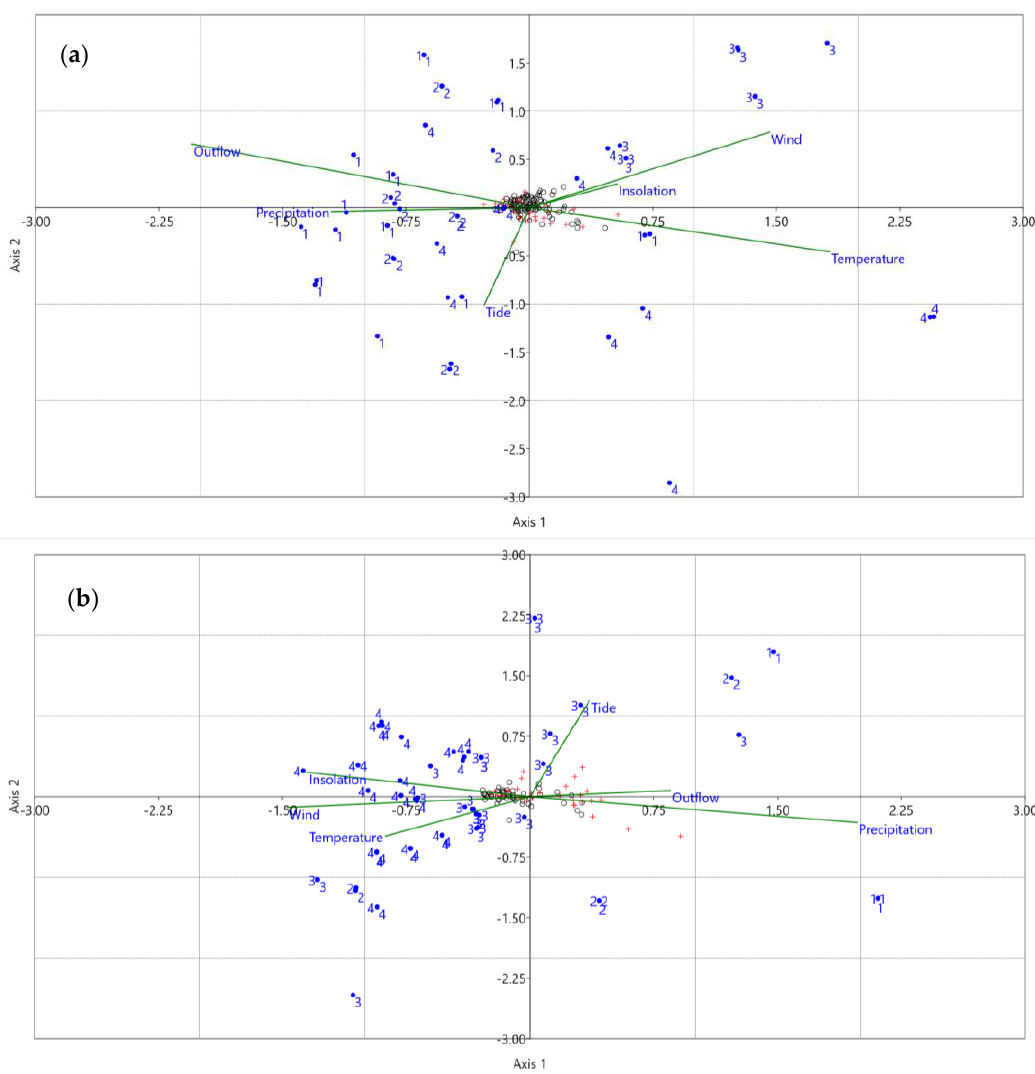
Figure 6. Canonical correspondence analysis (CCA) ordination diagram with spatial and temporal scores (points) and environmental variables (arrows) for ( a ) Mundaú and ( b ) Manguaba lagoons. Temporal scores were split into dry (o) and rainy (+) seasons, respectively. Spatial scores (●) were split by the HSG obtained from cluster analysis (see Figure 4).